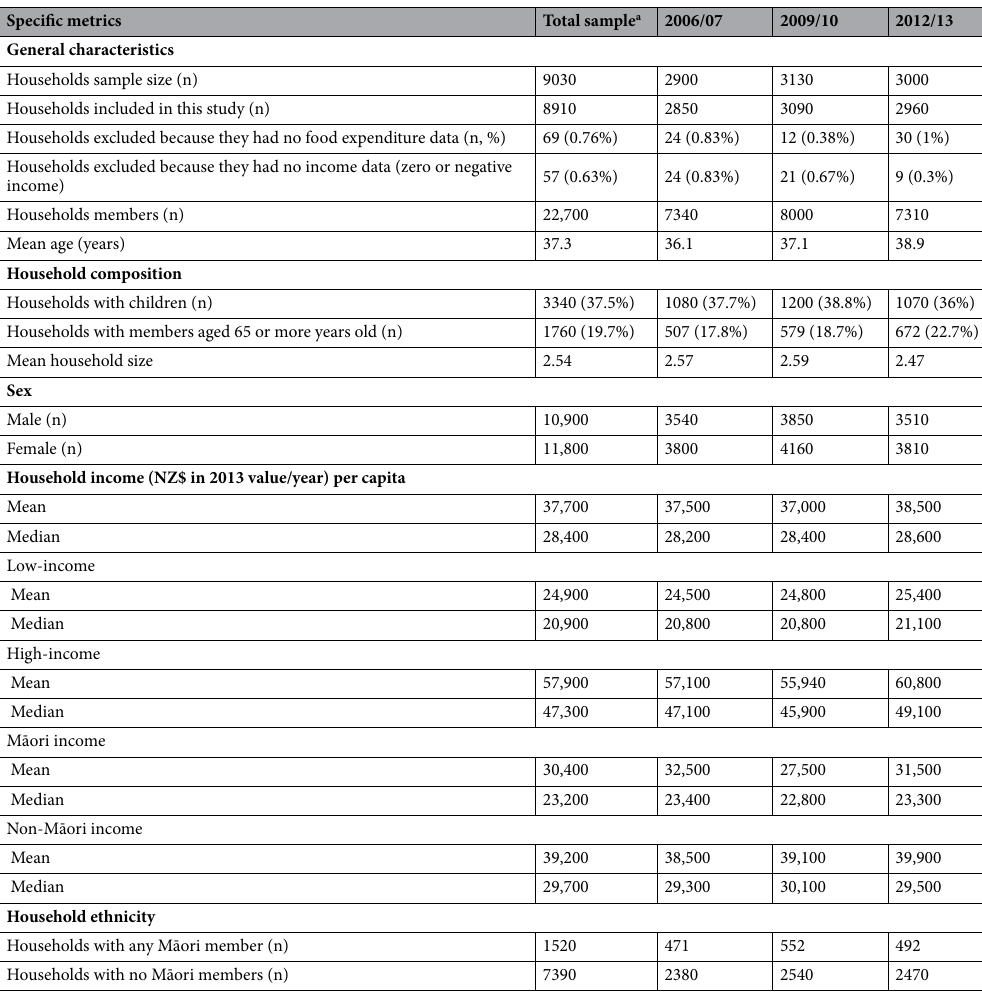
Table 1. Characteristics of repeated New Zealand Household Economic Survey samples. a Numbers may not add up exactly as they were randomly rounded to meet confidentiality requirements. All values in this Table were